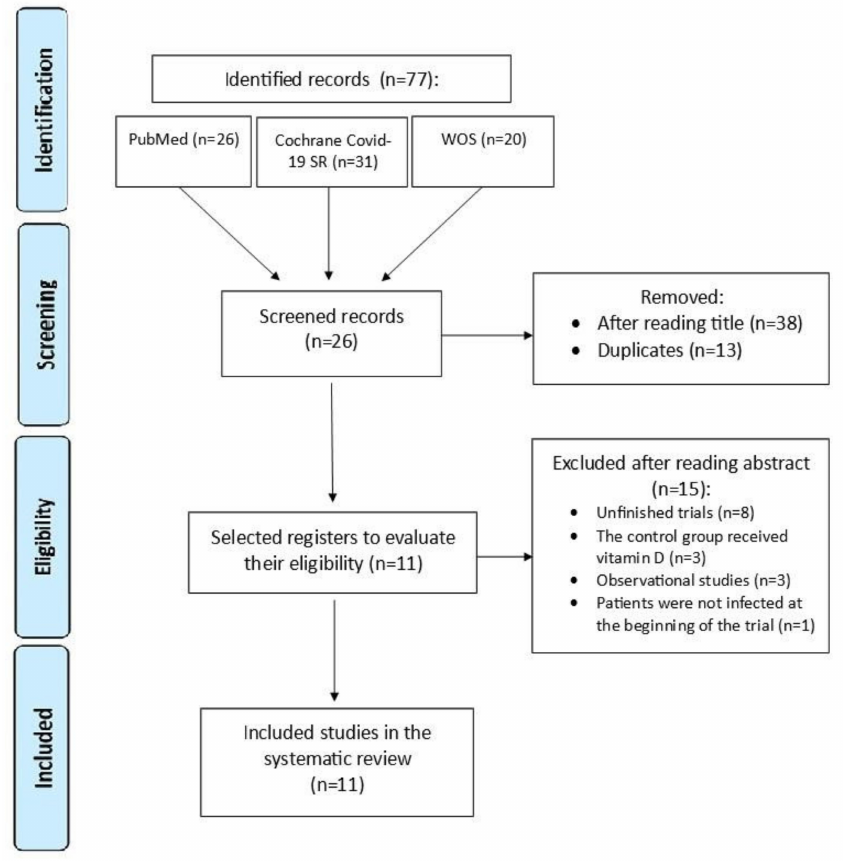
Figure 2. PRISMA flow chart at four levels.